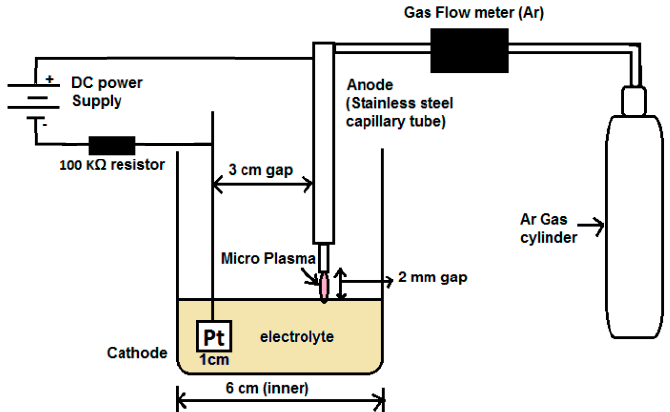
Figure 1. Schematic diagram of plasma–liquid interactions system employed to synthesize SF-AuNPs and DF-AuNPs [41].